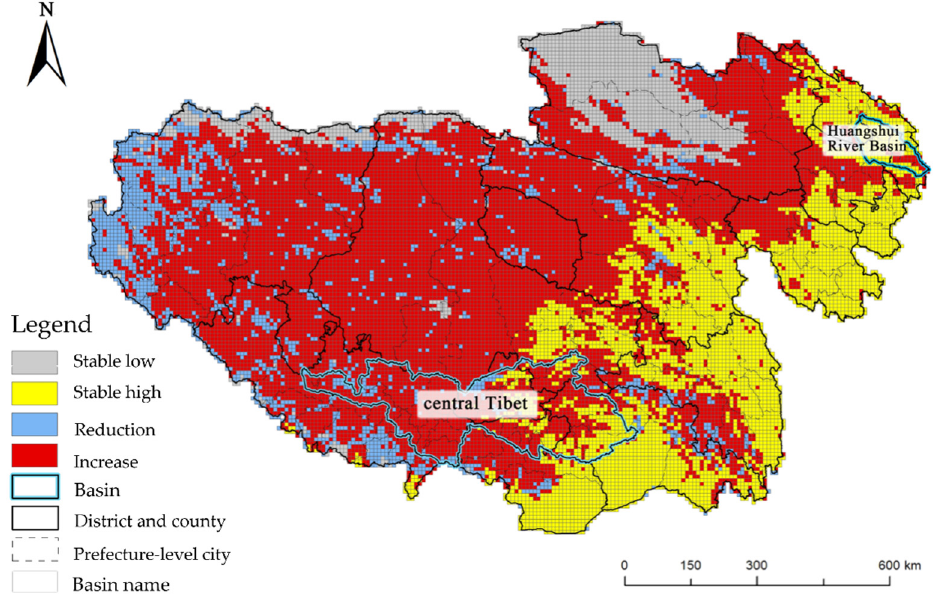
Figure 7. Aggregation results of long-time-series KNDVI.